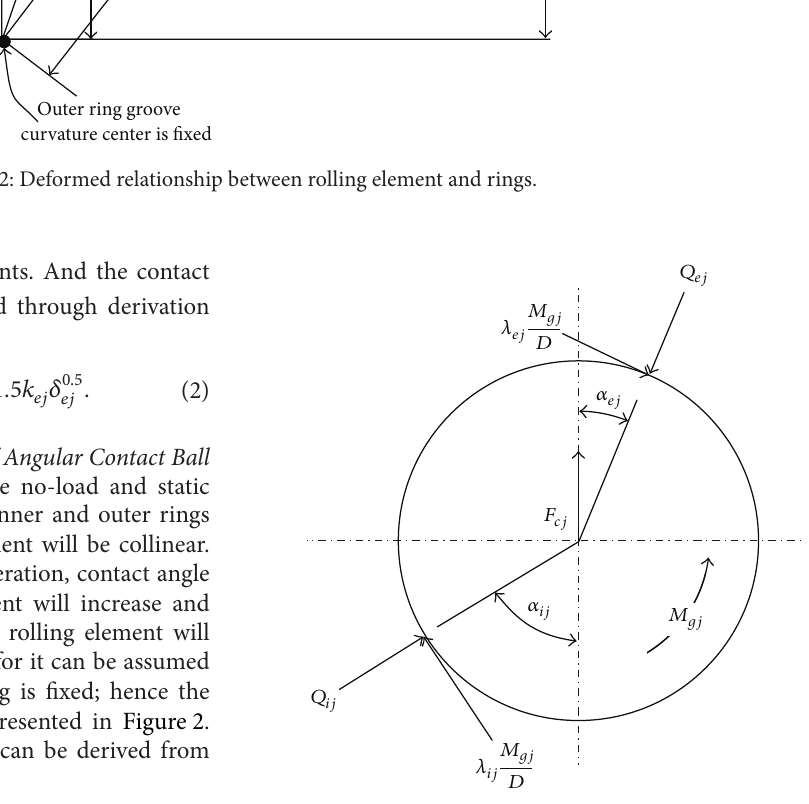
Figure 3: Mechanical analysis of rolling